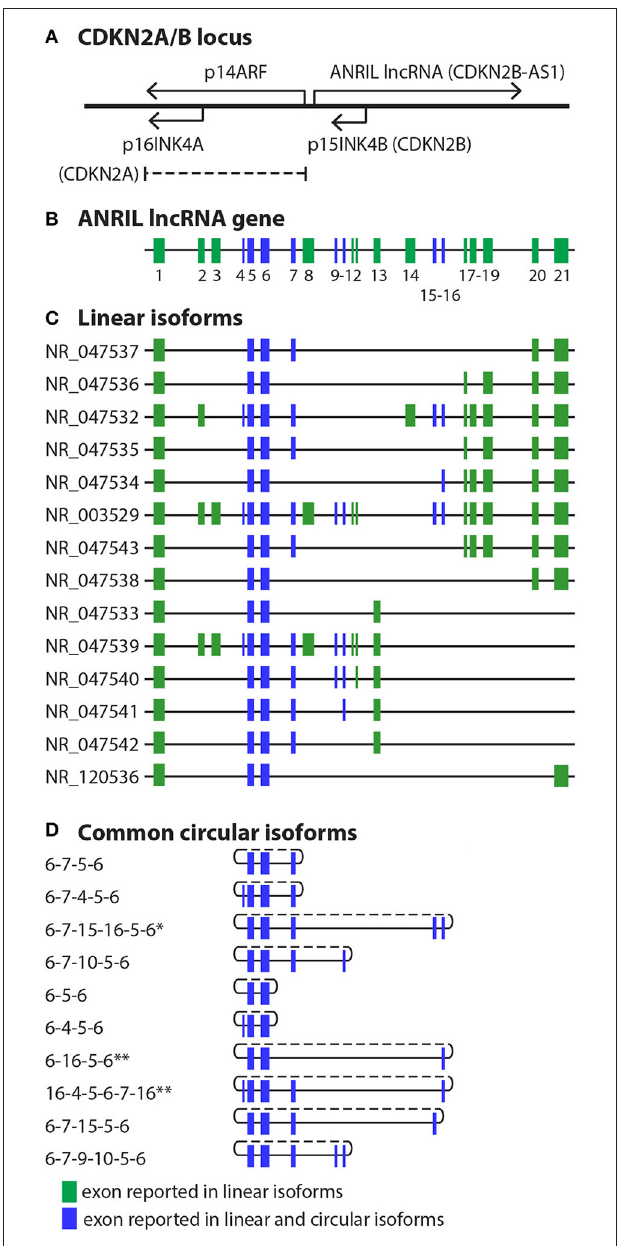
FIGURE 1 | CDKN2A/B locus and ANRIL isoforms. (A) At the CDKN2A/B locus, the ANRIL lncRNA is antisense to the protein coding genes. The p15INK4B gene is contained within intron 1 of ANRIL . (B) To date, ANRIL has 21 reported exons. (C,D) Numerous linear (C) and circular (D) exons have been reported. Due to the discovery of additional exons, distal exons in some circular isoforms have been renumbered based on the current 21 reported exons. *Exons 15-16 refer to exons 14-15 in Holdt et al. (6). **Exon 16 refers to exon 14 in Sarkar et al. (7) and Burd et al.